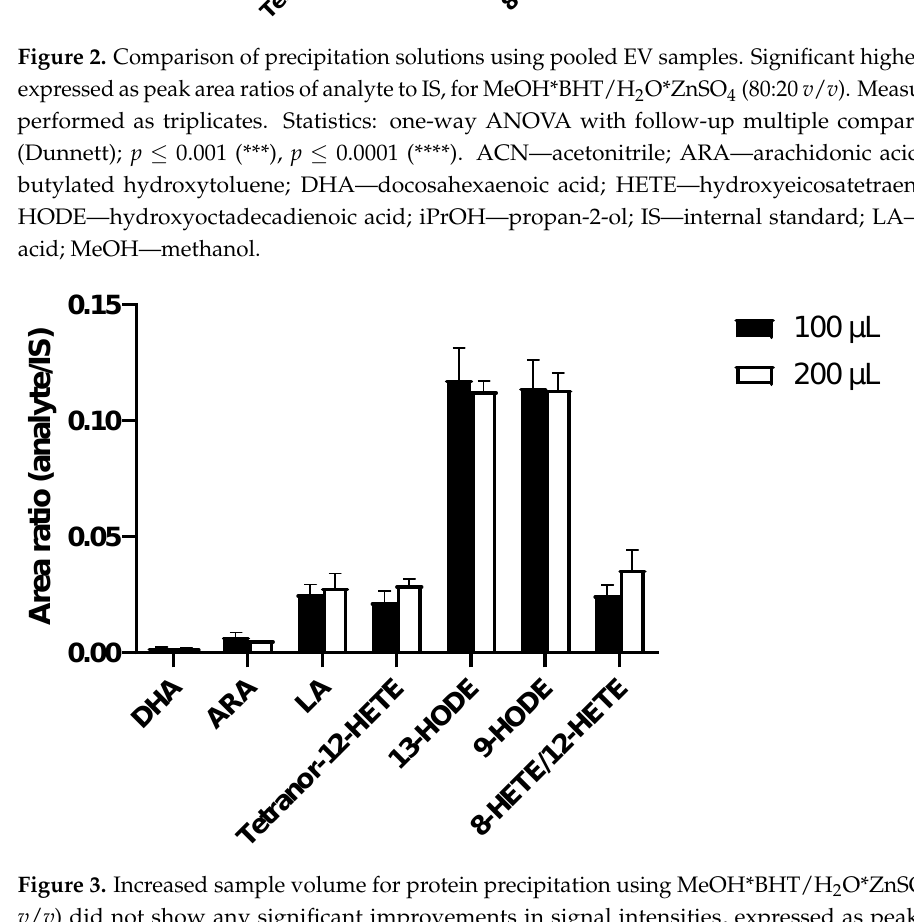
Figure 2. Comparison of precipitation solutions using pooled EV samples. Significant higher signals, expressed as peak area ratios of analyte to IS, for MeOH*BHT/H 2 O*ZnSO 4 (80:20 v / v ). Measurements performed as triplicates. Statistics: one-way ANOVA with follow-up multiple comparison test (Dunnett); p ≤ 0.001 (***), p ≤ 0.0001 (****). ACN — acetonitrile; ARA — arachidonic acid; BHT — bu-